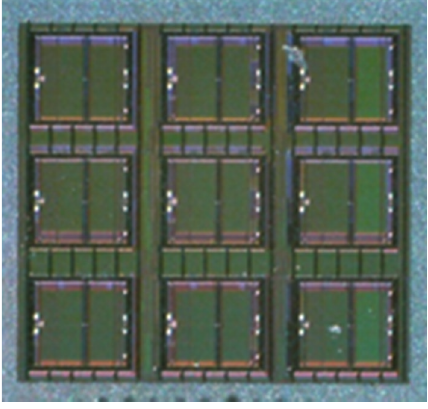
Figure 18: Asynchronous FPGA die